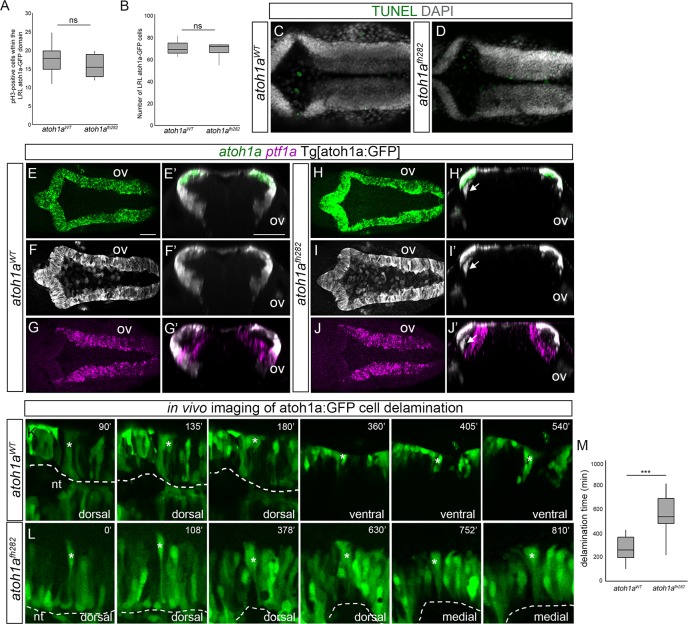
atoh1afh282 mutation does not result in changing the cell fate or cell loss.A-B) Box-plots with the quantification of mitotic figures within the LRL atoh1a:GFP cells (A), and the total number of LRL atoh1a:GFP cells (B), in atoh1aWT and atoh1afh282 embryos. C-D) atoh1aWT and atoh1afh282 embryos in the Tg[atoh1a:GFP] background were analyzed for apoptotic figures by TUNEL. Note that no differences between wild type and mutant embryos were observed (Table 2 for values and statistical analysis). E-G) atoh1aWT (n = 8) and (H-J) atoh1afh282 (n = 10) embryos in the Tg[atoh1a:GFP] background were concomitantly analyzed for atoh1a (E, H), atoh1a-derivatives visualized with anti-GFP staining (F, I) and ptf1a (G, J) expression. E’-J’) Reconstructed transverse views of dorsal views displayed in (E-J) at the level of the otic vesicle. Note that the atoh1a:GFP cells in the atoh1afh282 mutant did not migrate towards the differentiation domain and did not display ptf1a (see white arrow in H’-J’), indicating that progenitor cells did not switch fate. K-L) Time-lapse stills showing delamination from the LRL of tracked atoh1a:GFP cells (indicated with white asterisk) in atoh1aWT (n = 28) and atoh1afh282 (n = 12) embryos in the Tg[atoh1a:GFP] background. Dorsal views of hemi-neural tubes (dashed white line indicates the apical region of the hindbrain), with anterior to the left and lateral at the top. Numbers at the top-right indicate the minutes after the beginning of the movie. Note that in wild type embryos, the cell delaminates and migrates towards ventral, allocating in the corresponding neuronal differentiation zone (see the first three dorsal frames and then the following ventral ones), whereas in atoh1afh282 embryos the indicated cell remains within the dorsal epithelium (see that there are four dorsal and two medial frames because the cell never reaches ventral). M) Box-plot indicating the time of delamination from the LRL of atoh1a:GFP cells in atoh1aWT and atoh1afh282 embryos. Note that cells from wild type embryos exit the LRL much earlier than the cells from mutant siblings. Since the atoh1afh282 mutant allele only caused a deleterious phenotype in homozygosity, wild type and heterozygous conditions showed identical phenotypes and they were displayed as single wild type condition. nt; neural tube lumen; ov, otic vesicle. Scale bars correspond to 50 μm. ns, non-statistically significant; *** p<0.001.